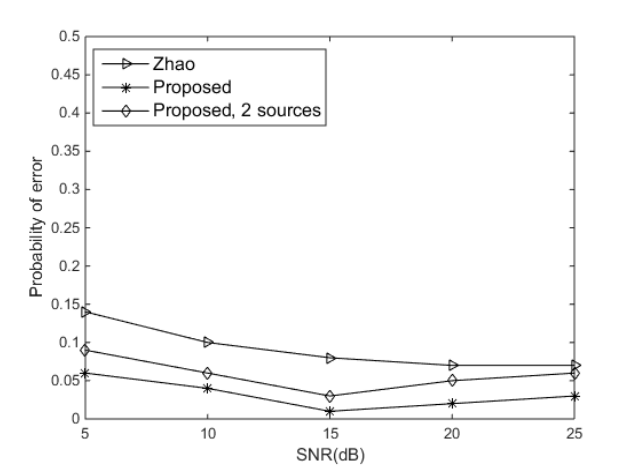
Figure 4. Probability of error versus signal-to-noise ratio